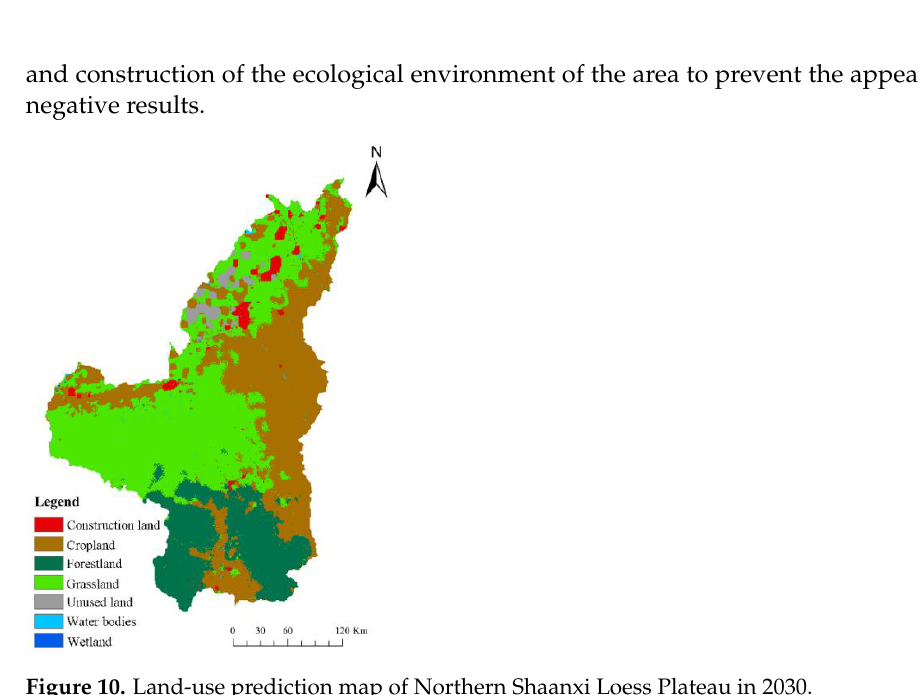
Figure 10. Land-use prediction map of Northern Shaanxi Loess Plateau in 2030. Table 12. Forecast of ESV in the Loess Plateau of Northern Shaanxi in 2030. Unit: CNY 100 million. Cropland Forestland Grassland Wetland 85.67 171.10 171.62 0.65